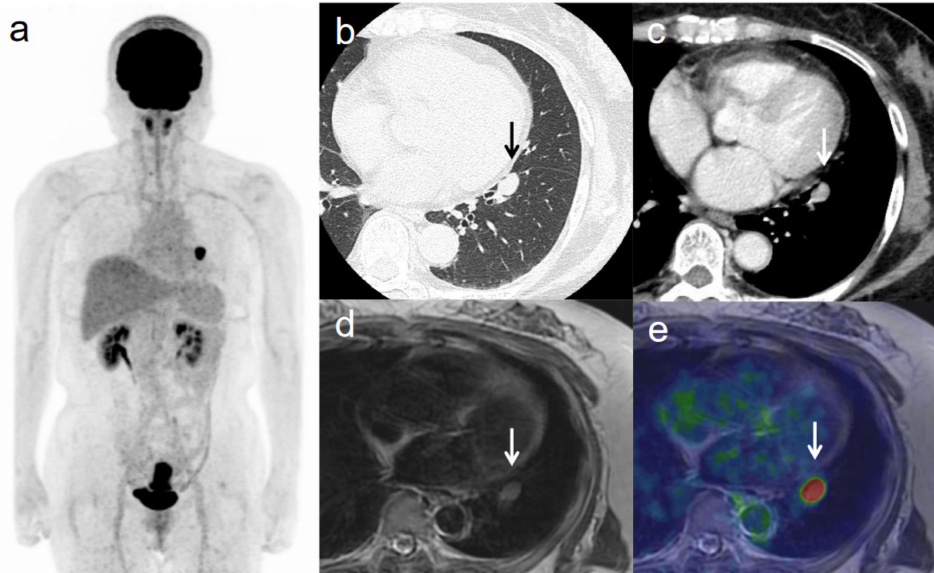
Figure 5. A 63-year-old woman with IVB cervical cancer and lung metastasis. ( a ) 18 F-FDG PET image shows FDG uptake by tumor in the cervical cervix (arrow) and a lung nodule. ( b ) CT with lung window setting shows a lung nodule of short-axis diameter >1 cm (arrow). ( c ) CT of a lung nodule of short-axis diameter >1 cm (arrow). ( d ) Axial T2-weighted image shows a lung nodule of short-axis diameter >1 cm (arrow). ( e ) Axial T2-weighted PET/MR image shows FDG uptake by the lung nodule (arrow). This finding is strongly suggestive of lung metastasis, which was confirmed by histopathologic